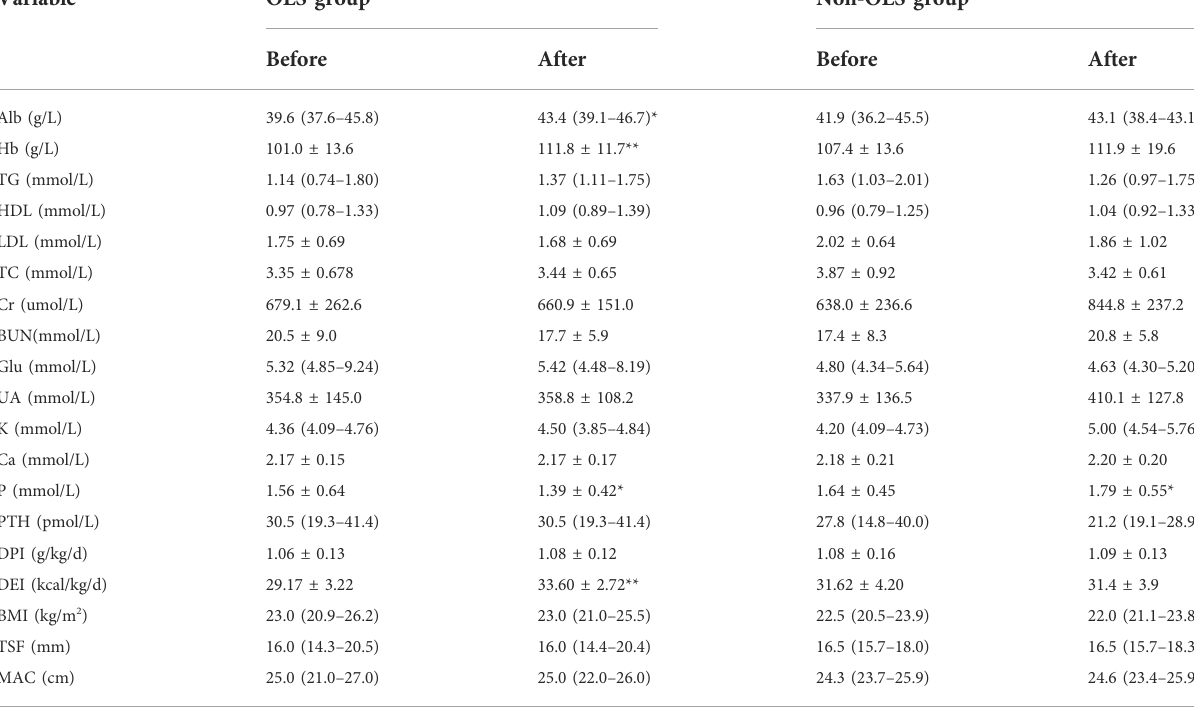
TABLE 2 Change in biochemical parameters, food intake, and body composition between the two groups. Variable OES group Before After Before After